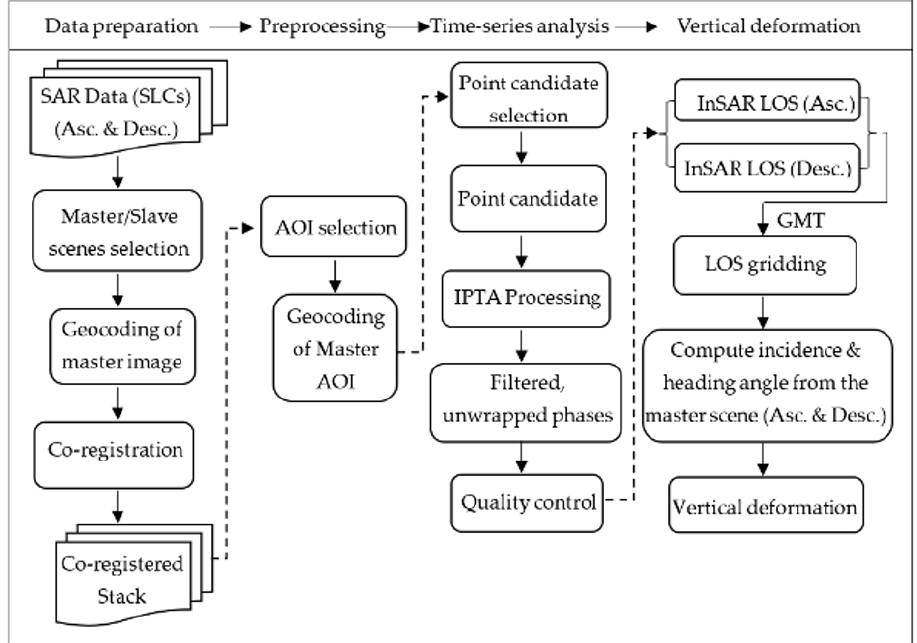
Figure 5. The flowchart of deriving tunneling-induced ground deformation from the PSInSAR TM technique.